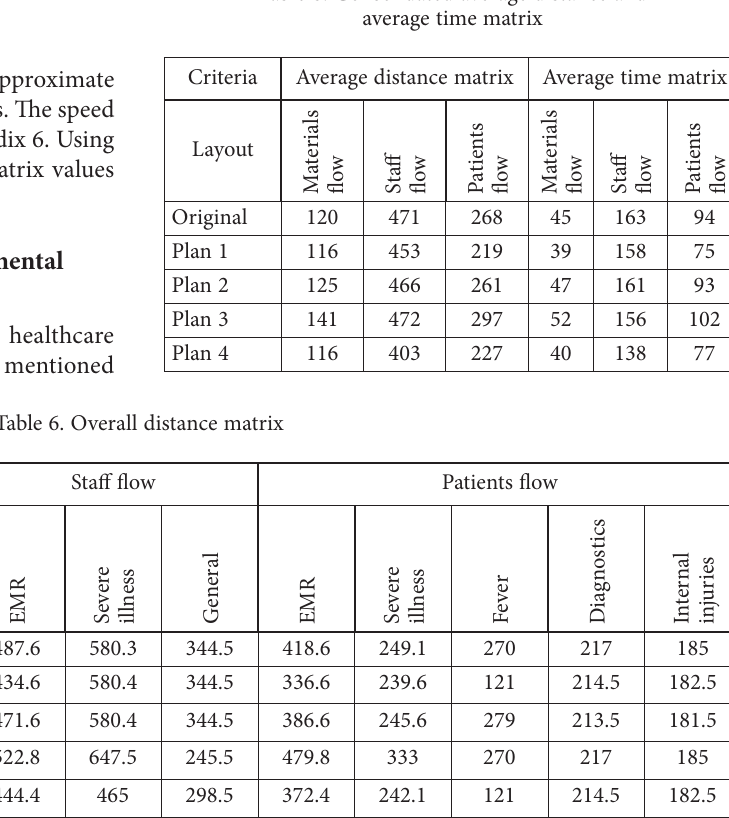
Table 8. Consolidated average distance and